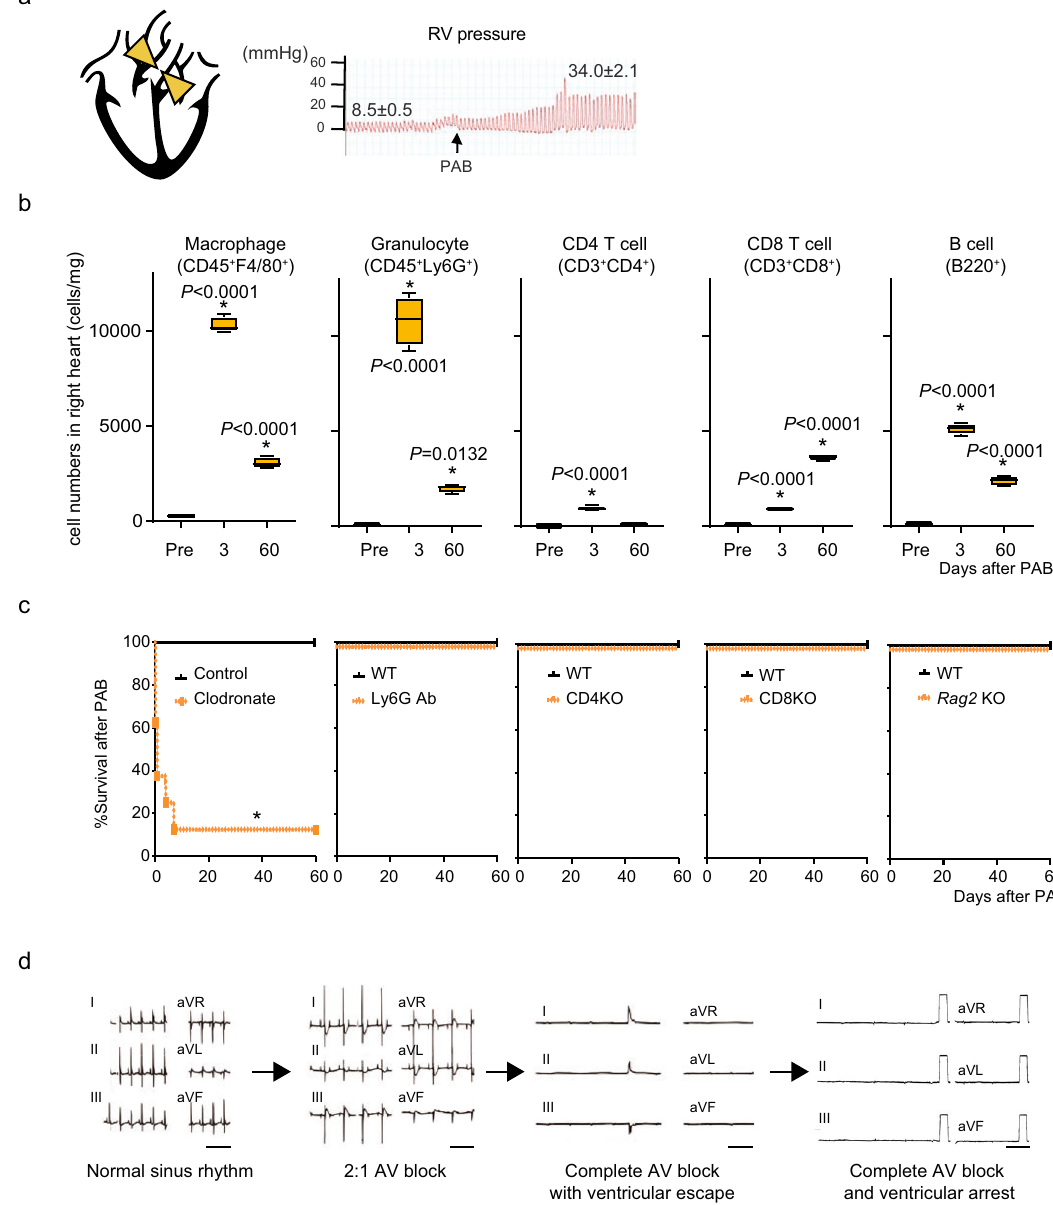
Fig. 1 Macrophage depletion causes sudden death after right heart stress. a Mouse model of right heart pressure overload (PAB). The pulmonary artery was ligated to increase the RV pressure to 30-35 mmHg from 5-10 mmHg. b Flow cytometric analysis of immune cells in the right atrial (RA) and RV free wall in wild-type (WT) mice after PAB. n = 4 in each group. One-way ANOVA followed by Tukey ’ s post-hoc test. * P < 0.05 vs. pre: steady-state. Box plots show center line as median, box limits as upper and lower quartiles, whiskers as minimum to maximum values. c Effects of depleting macrophages (clodronate), granulocytes (Ly6G Ab), CD4 + (CD4KO) or CD8 T + (CD8KO) cells, or T and B cells ( Rag2 KO) on survival after PAB. * P < 0.0001 (log-rank test). d Representative six-channel ECGs from clodronate-treated mice after PAB. Shown is the representative sequence of arrhythmia progression observed in a mouse. Bars, 400